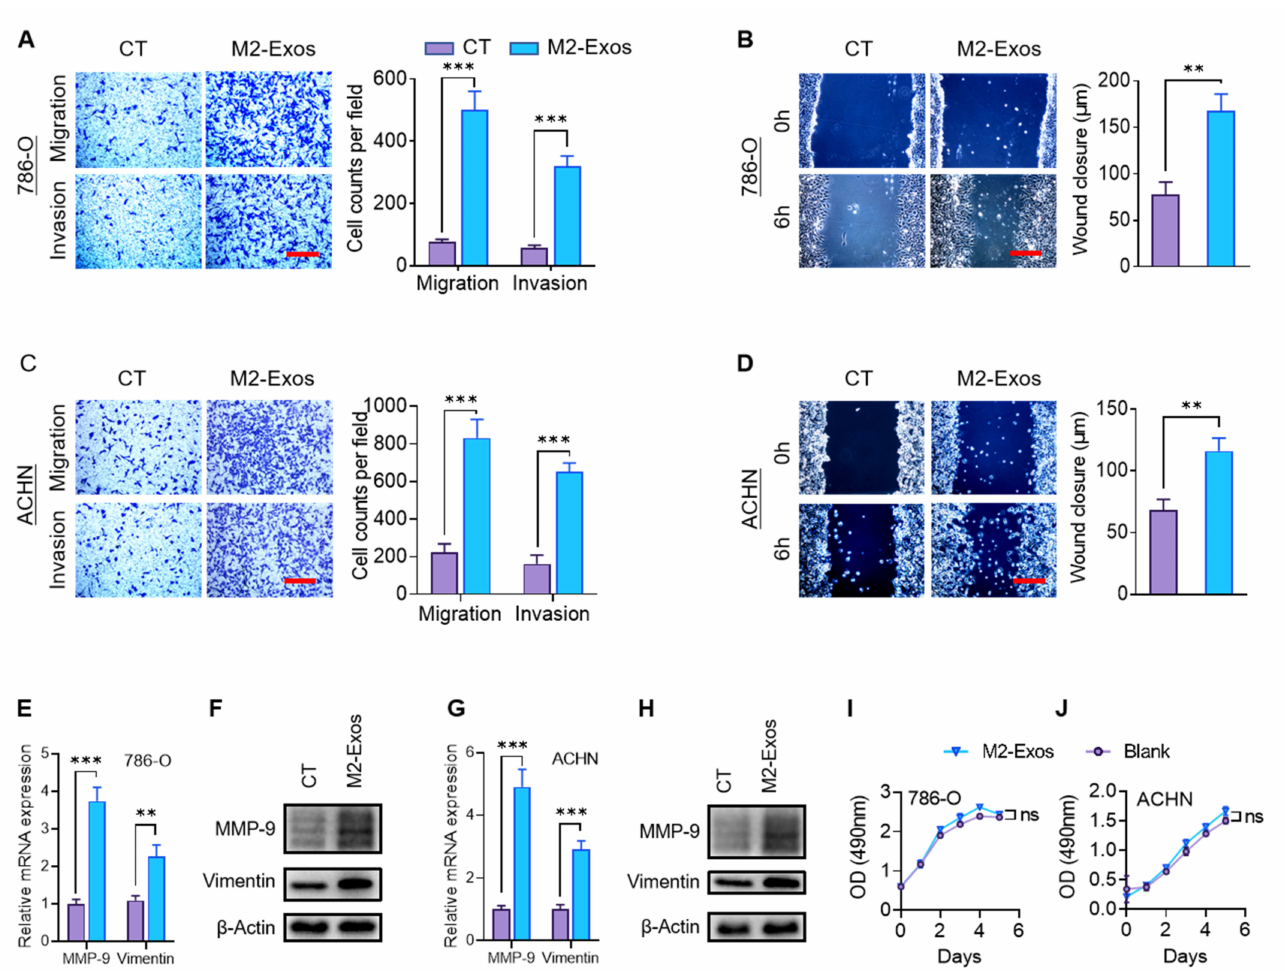
Figure 3. M2-Exos promote RCC migration and invasion. 786-O and ACHN cells treated with or with- out M2-Exos. ( A – D ) The impact of the M2-Exos treatment on the migration and invasion capabilities of RCC cells was analyzed by transwell ( A , C ) and wound-healing assays ( B , D ). Scale bar: 100 µ m. ( E , F ) The impact of M2-Exos treatment on RCC cell: mRNA ( E , G ) and protein expression ( F , H ) of MMP-9 and vimentin were assayed by RT-qPCR and western blotting, respectively. ( I , J ) The impact of M2-Exos treatment on cell proliferation was analyzed by MTT assay. ** p < 0.01, *** p < 0.001. CT: